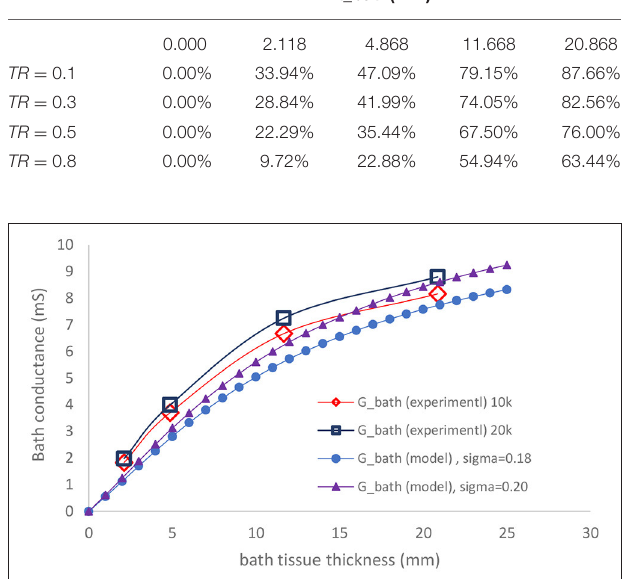
Frontiers in Physiology |